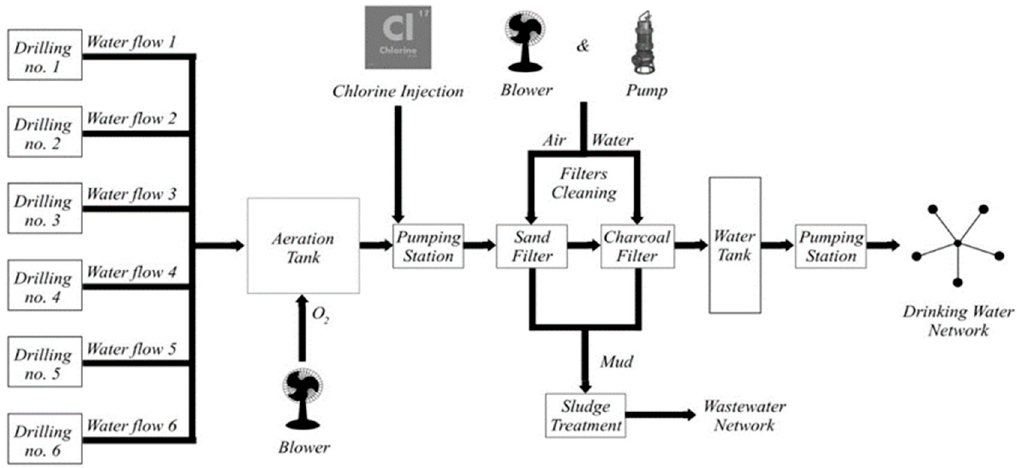
Figure 1. The processes inside a drinking water treatment plant.